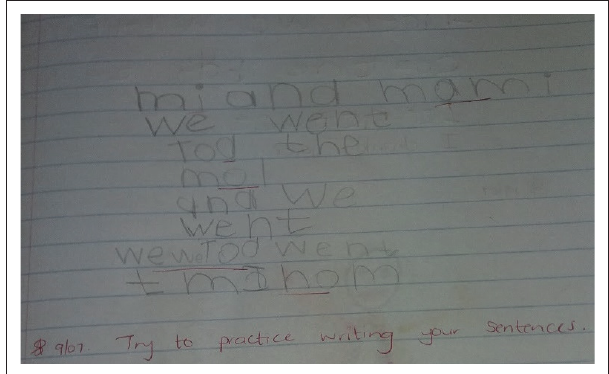
FIGURE 3: Baseline assessment task of an English Second Language learner.